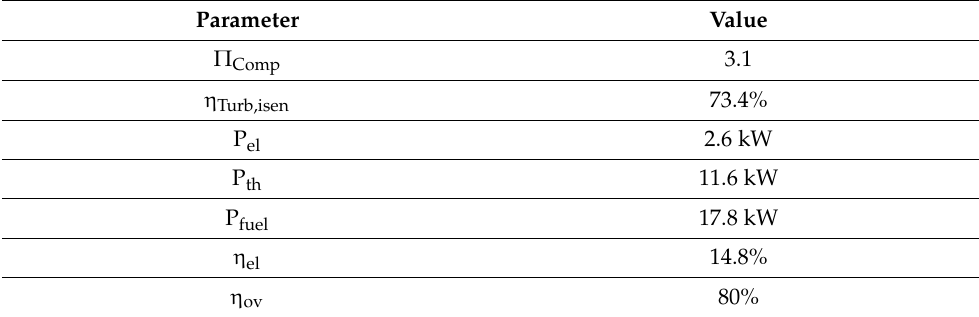
Table 3. Simulated performance data of the MGT at full